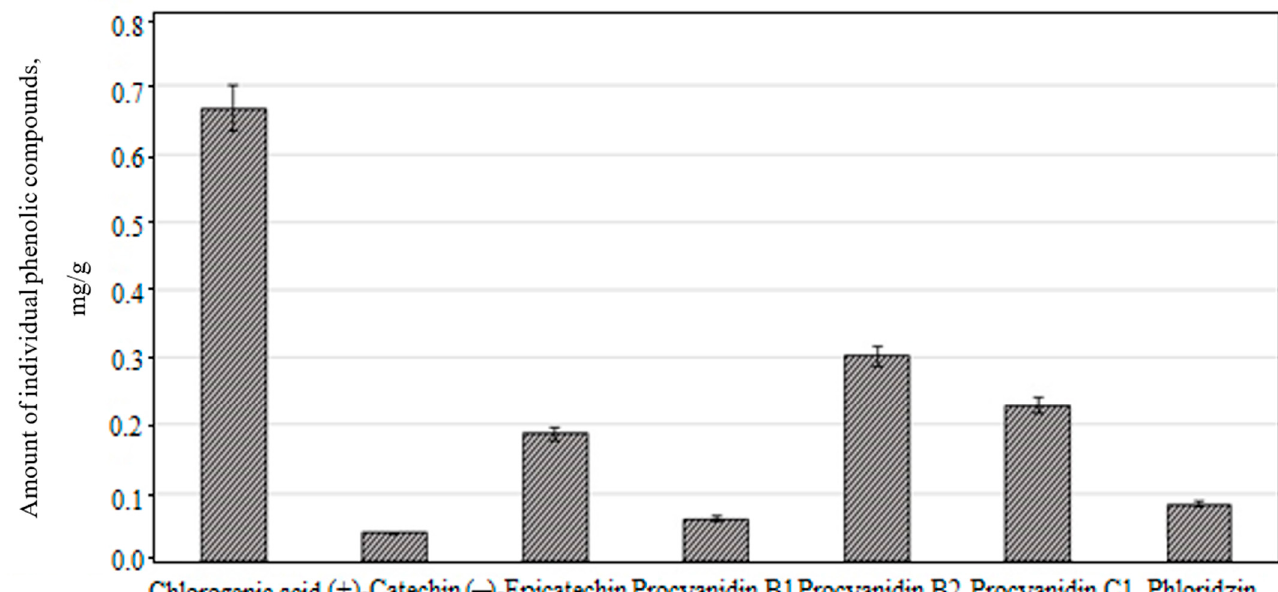
Figure 2. The amount of individual flavan-3-ols, phloridzin, and chlorogenic acid in ethanol extracts obtained from the apple fruit of the “Ligol” cultivar grown in Lithuania.